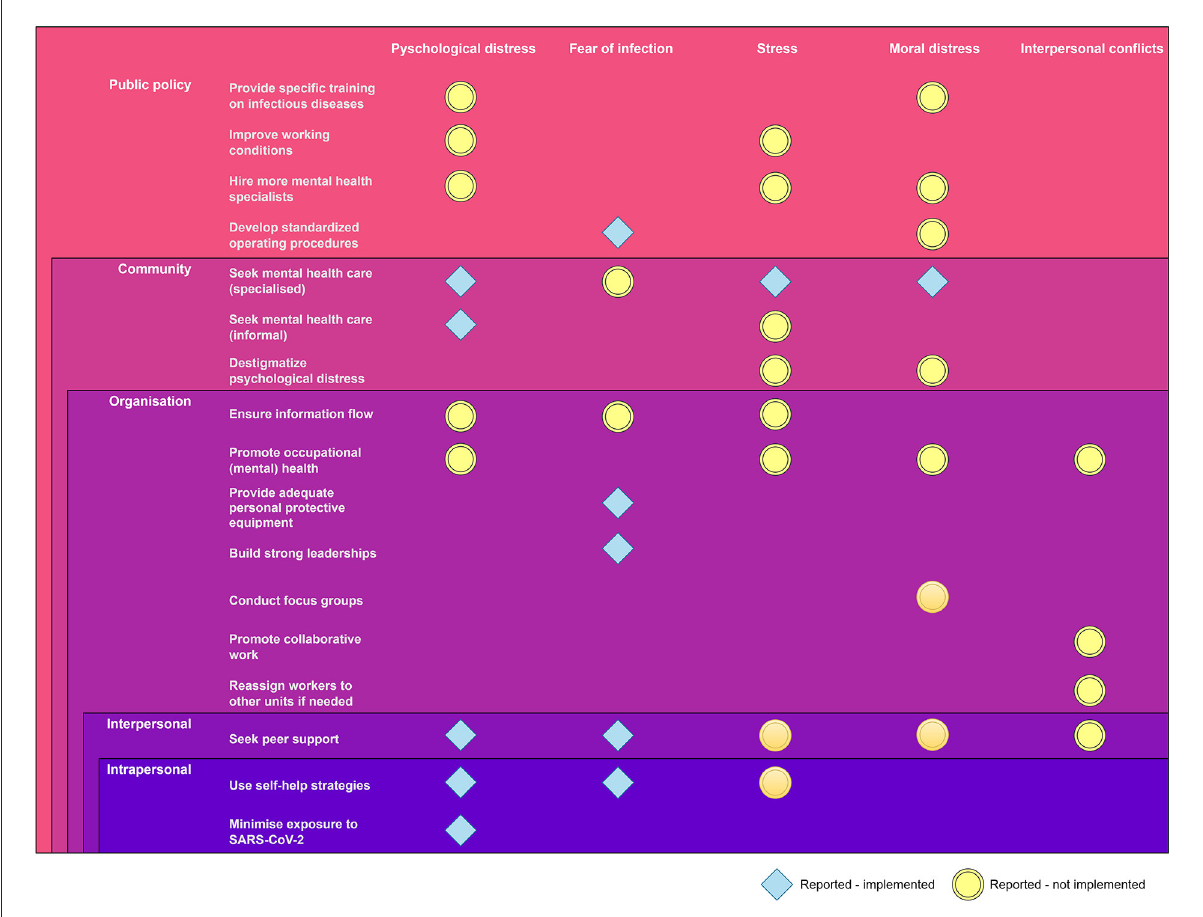
FIGURE2 Strategies currently implemented (blue rhombus shapes) or requiring implementation (yellow circles) to improve frontline HCWs’ mental health problems, as perceived by KI interviewees.